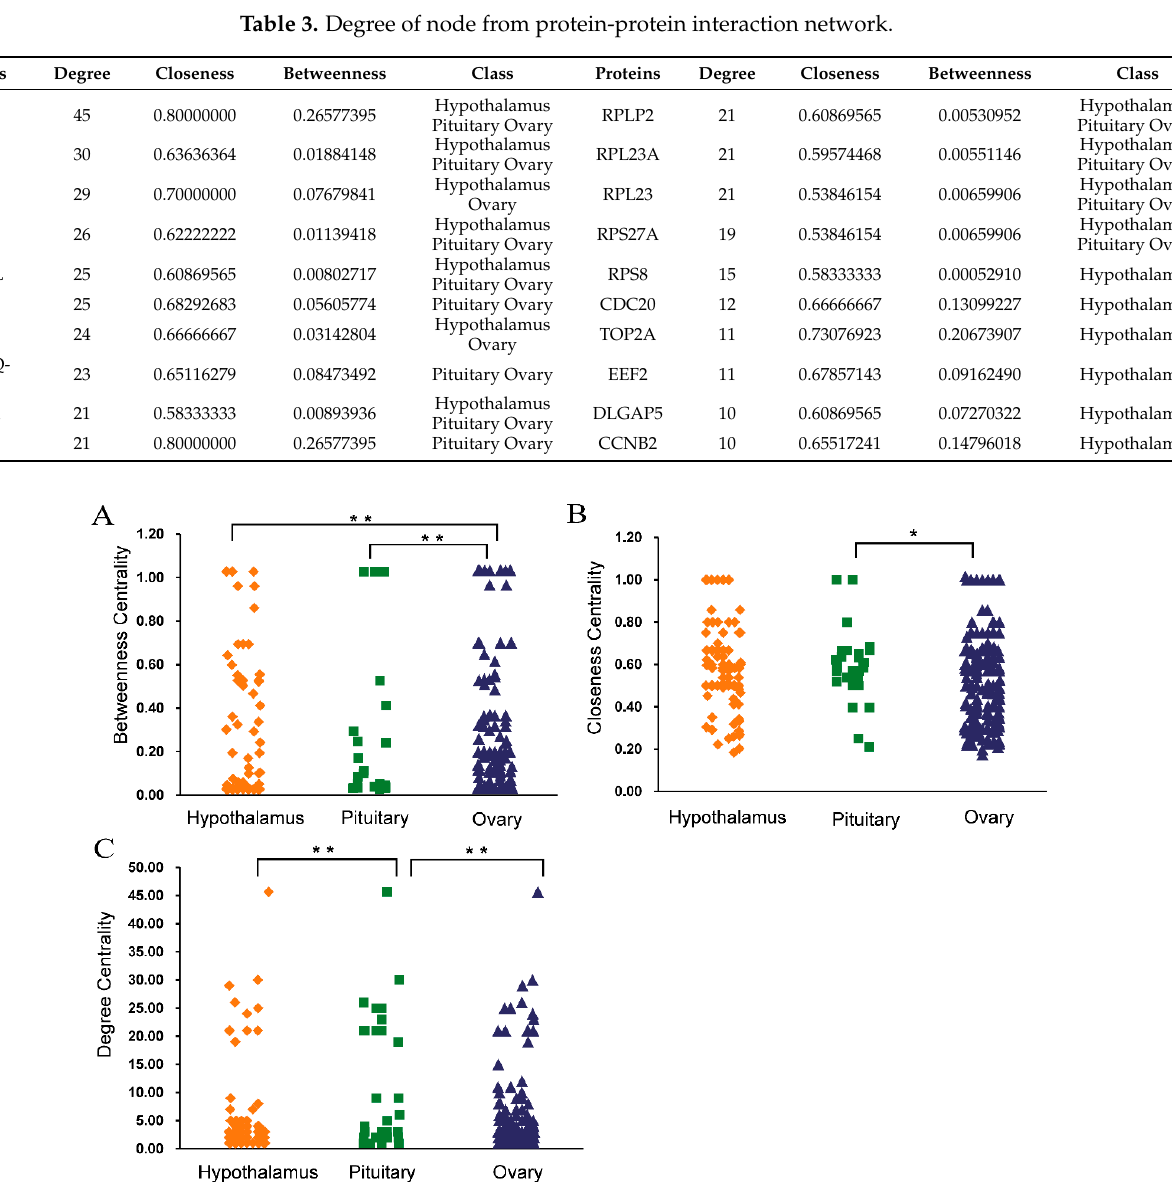
Figure 12. The differences in the betweenness, closeness, and degree centrality among hypothalamus, pituitary and ovary ( A ) The scatterplot of betweenness centrality. ( B ) The scatterplot of closeness centrality ( C ) The scatterplot of degree centrality. The significant results with a p -value lower than 0.05 are given one asterisk (*). The extremely significant results with a p -value lower than 0.01 are given two asterisks (**).